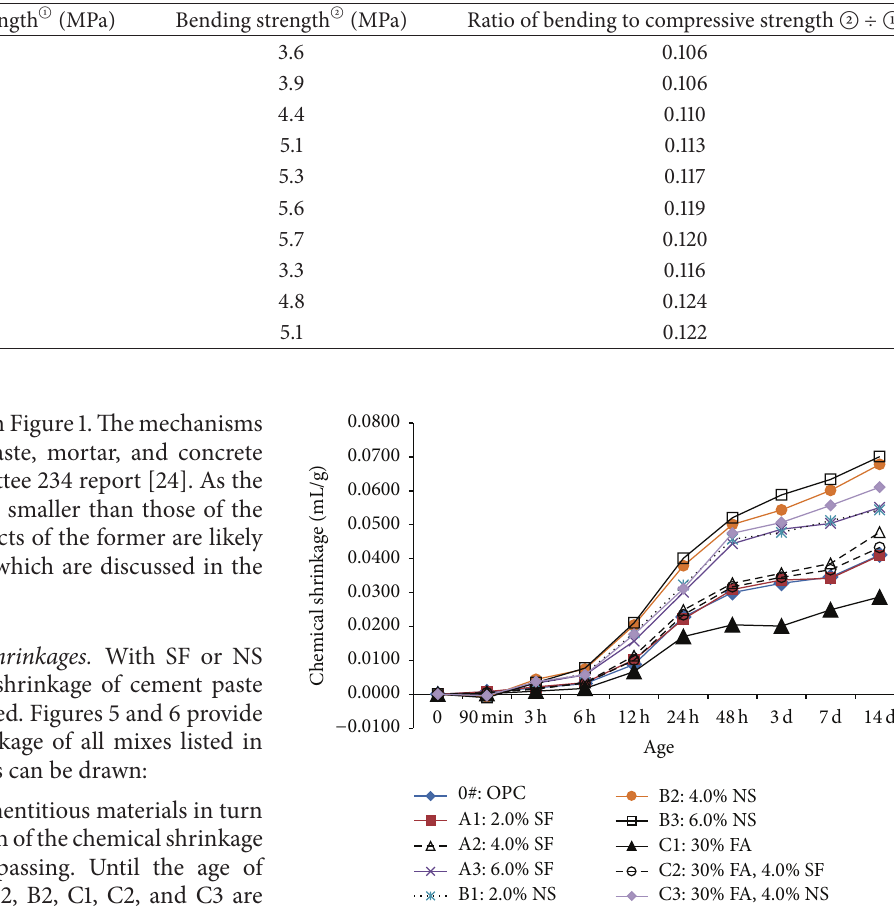
Table 4: Strength and ratio of bending to compressive strength of hardened cement paste at 7 d.